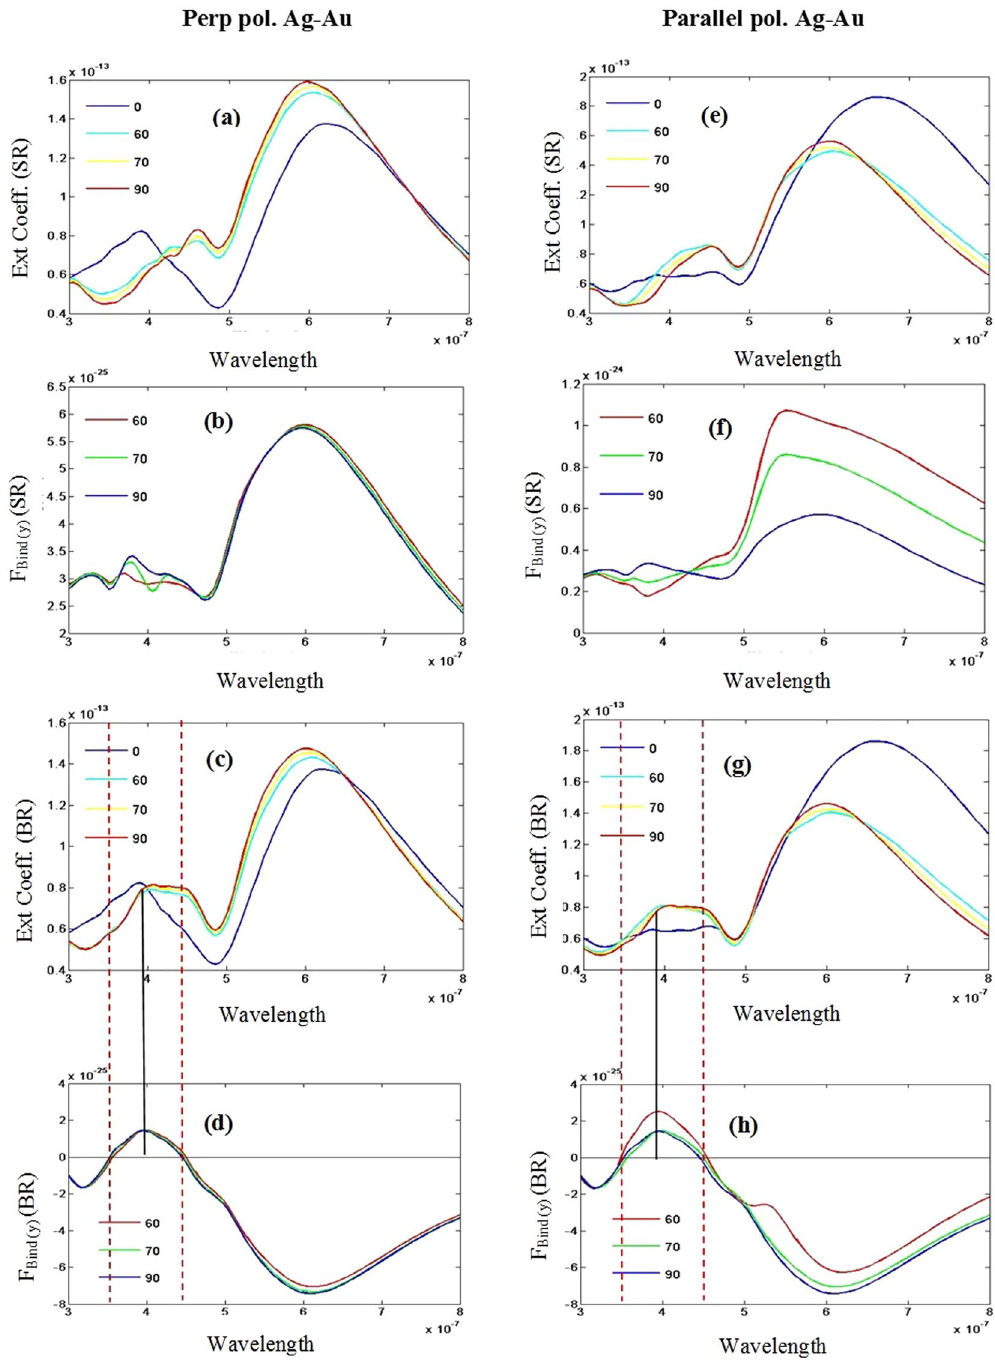
Figure 4. SR and BR represent ‘small rotate’ and ‘big rotate’ respectively and ‘ ȹ ’ = 60, 70 and 90 degree [off axis Ag-Au]. All wavelengths are in meter (m) unit. All Forces are in Newton (N) unit. Considering perpendicular polarized light- for the configuration of Fig. 1(a) ( a ) Extinction co-efficient (SR) ( b ) The longitudinal binding force F Bind(y) (SR); and for the configuration of Fig. 1(d) ( c ) Extinction co-efficient (BR) ( d ) the longitudinal binding force F Bind(y) (BR). Considering parallel polarized light: for the configuration of Fig. 1(a) ( e ) Extinction co-efficient (SR) ( f ) The longitudinal binding force F Bind(y) (SR); and for the configuration of Fig. 1(d) ( g ) Extinction co-efficient (BR) ( h ) The longitudinal binding force F Bind(y)